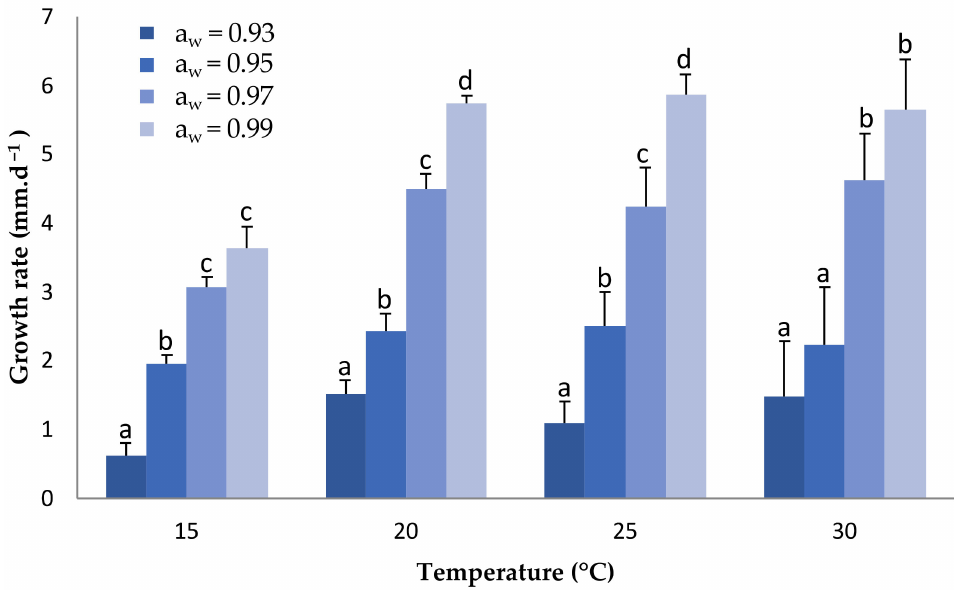
Figure 2. Average mycelial growth of isolates of F. oxysporum associated with vascular wilt on asparagus at different regimes of temperature and water activity (a w ). Bars with the same lower case letter did not differ significantly p ≤ 0.05.